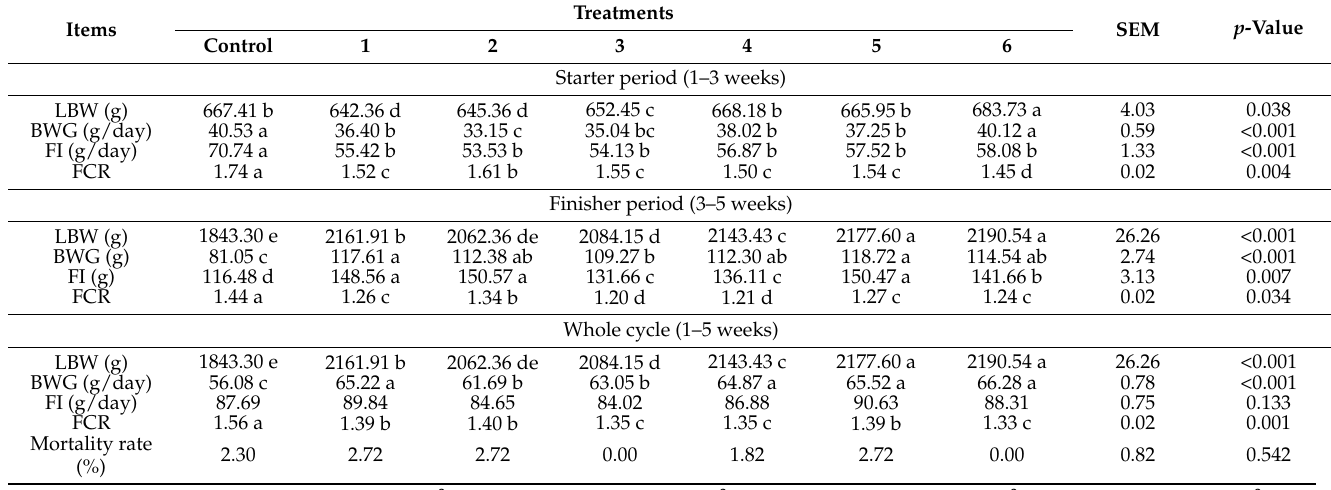
Table 3. Live body weight (g), body weight gain (g), feed intake (g), feed conversion ratio and mortality rate (%) of broilers as affected by dietary supplementation of ZnNPs, CurNPs, and Bl . ( n = 60/treatment).